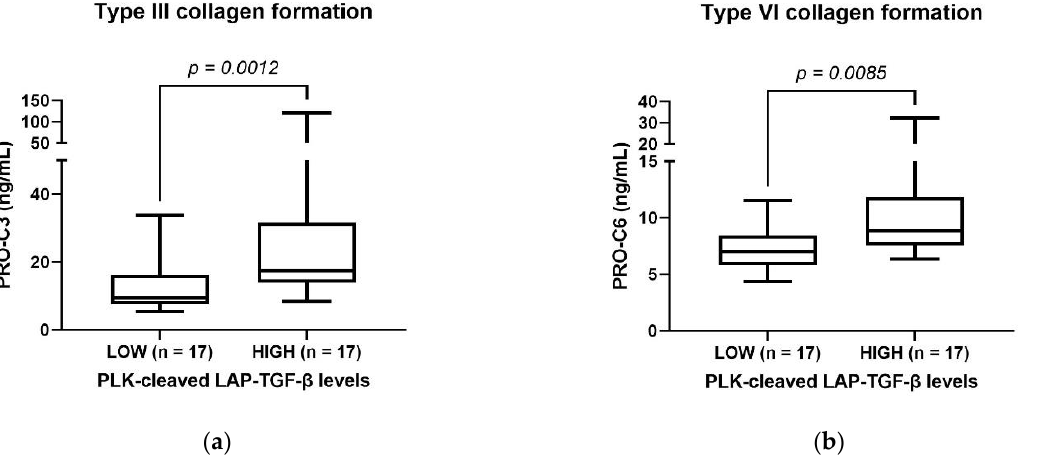
Figure 6. PLK-cleaved LAP-TGF- β levels associate with collagen formation: Biomarker levels of PRO-C3 ( a ) and PRO-C6 ( b ) from patients with PDAC dichotomized into low PLK-cleaved LAP-TGF- β levels (< median, n = 17) and high PLK-cleaved LAP-TGF- β levels (> median, n = 17). The groups were compared using Mann-Whitney test; p -value is shown.